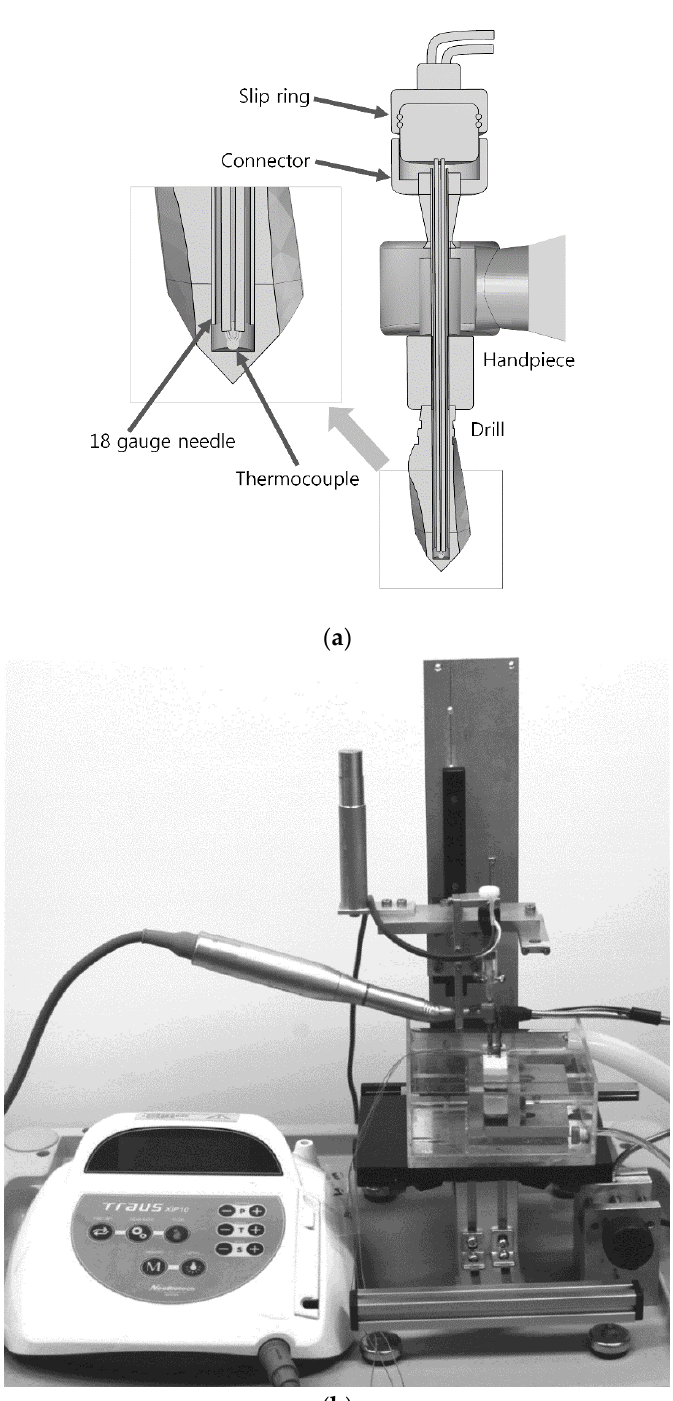
Figure 1. ( a ) A sectional view of the drill and slip ring assembly; ( b ) A custom-made experimental device and drilling motor.